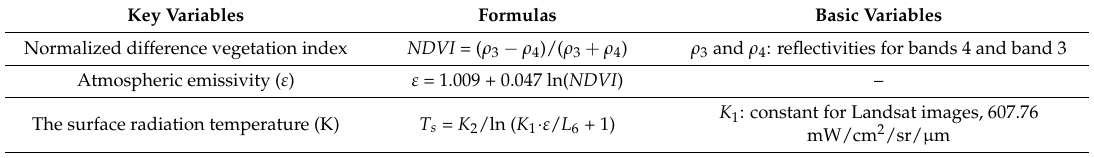
Table 2. The key variables and formulas of the Surface Energy Balance Algorithm